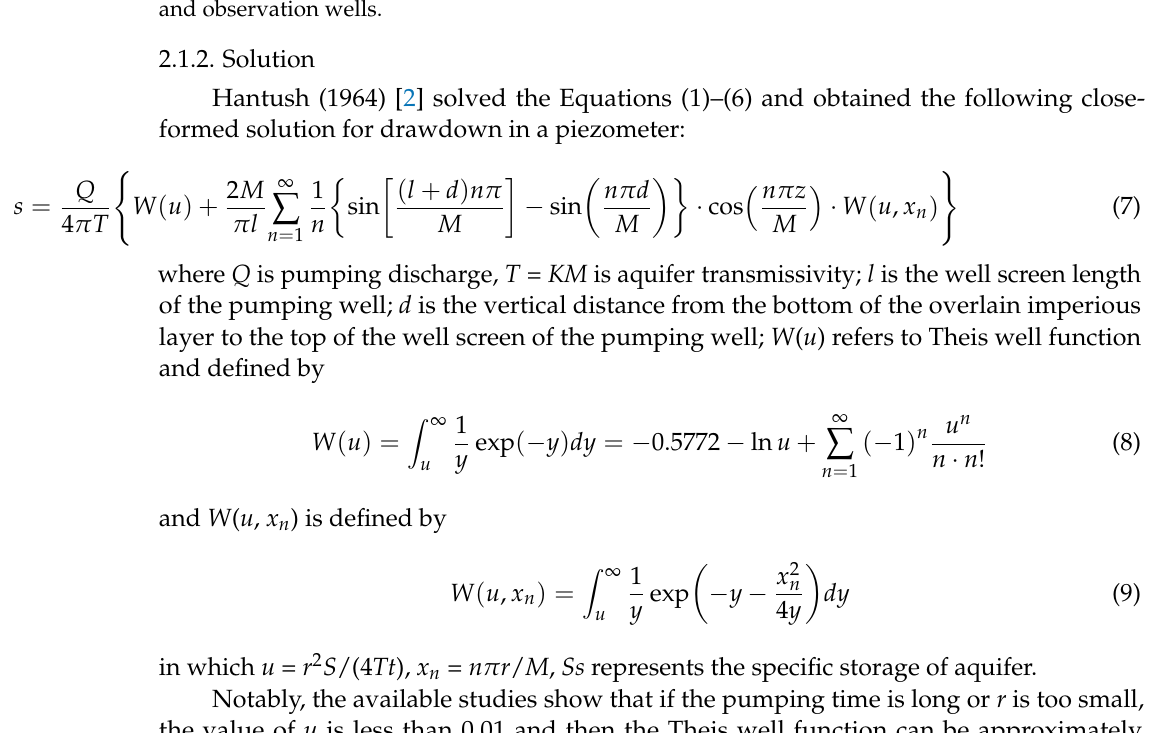
Figure 1. Schematic representation of an infinite confined aquifer partially penetrated by pumping and observation wells.